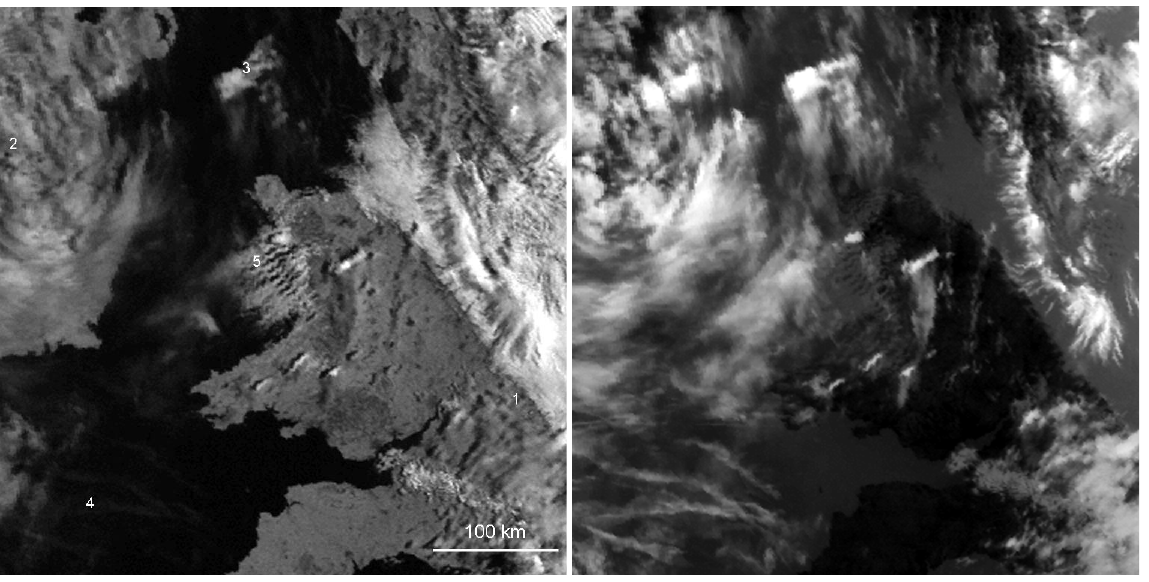
Fig. 2. (a) Visible-light satellite image at 07:30UT on 15 June 1995, approximately 7.5 ◦ –1 ◦ W, 50.5 ◦ –54.5 ◦ N. North is at the top. It shows Wales in the centre, parts of England (1) and Ireland (2), and the Isle of Man (3). There are contrails (4), mountain lee-wave clouds (5) already discussed by Worthington (2001), and some strange cloud bars with the same alignment as the lee waves (the largest is about 80km east of label 5). Image supplied by the Satellite Receiving Station, Dundee University, Scotland. (b) Infrared version of (a), revealing extensive thin high cloud, and fallstreaks downwind of two of the cloud